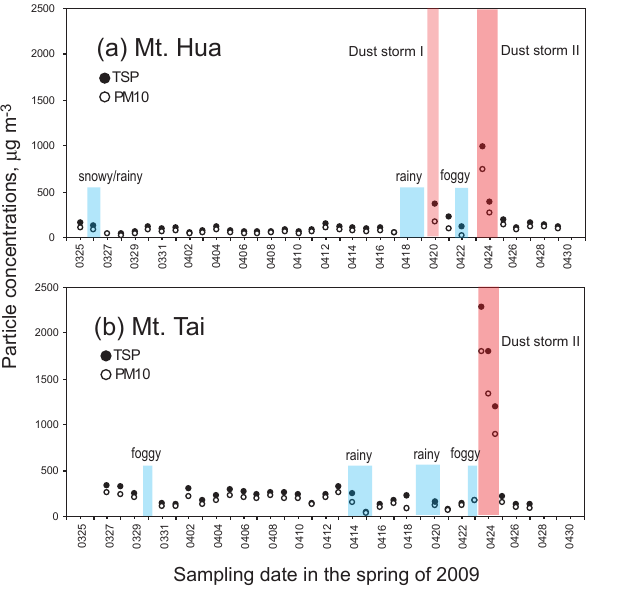
Fig. 3 TSP and PM 10 concentrations in the atmospheres over Mt. Hua and Mt. Tai during spring 2009